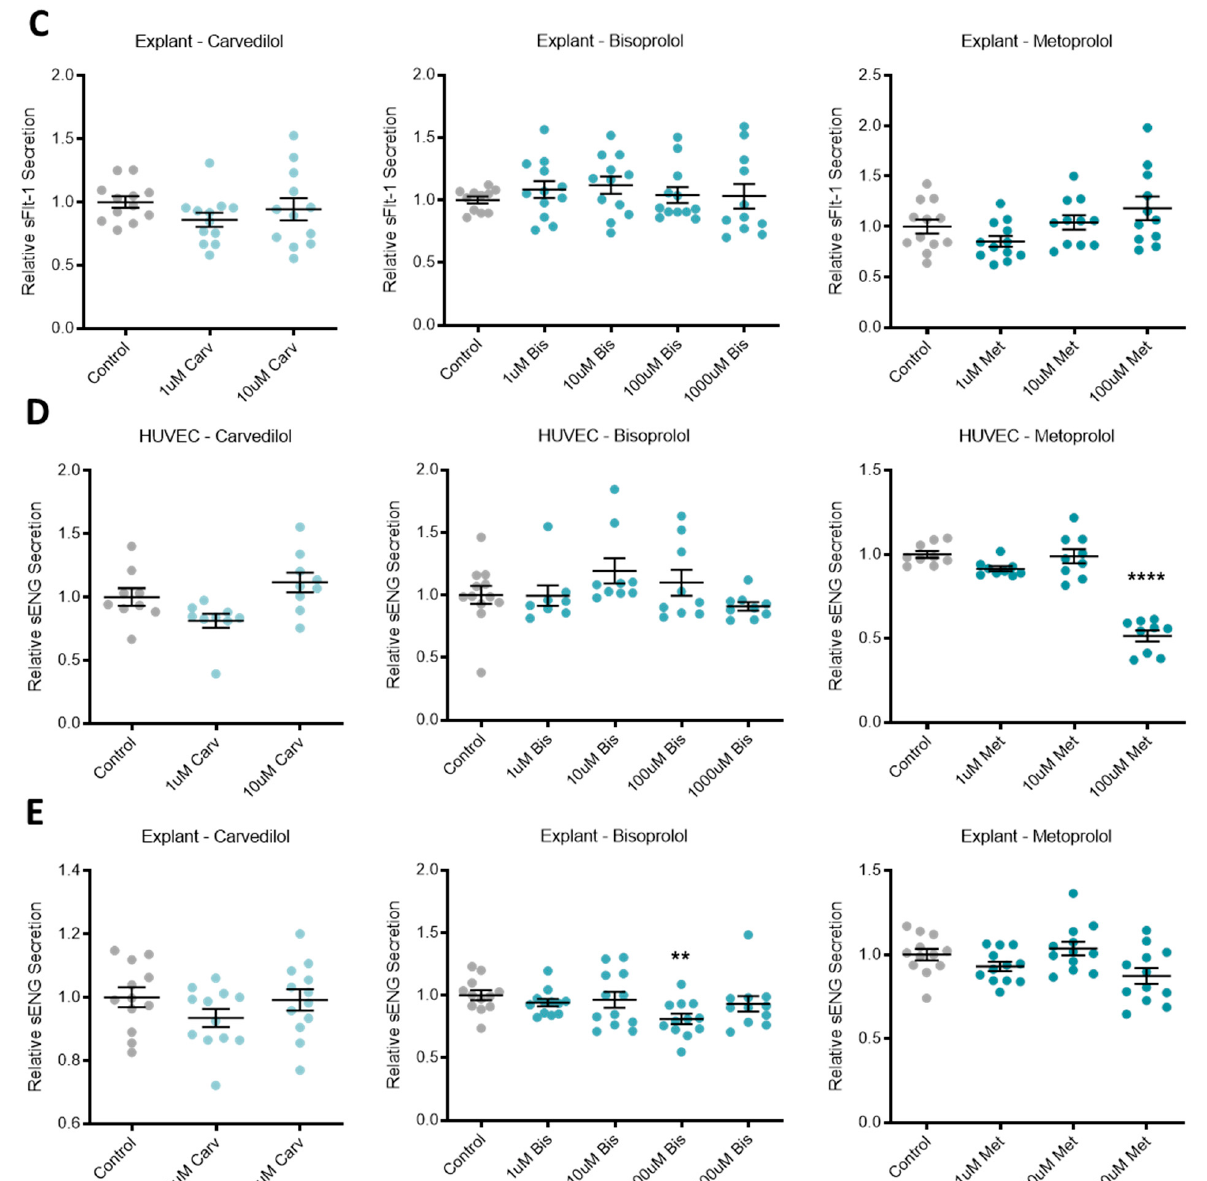
Figure 1. Beta-blockers had limited effect on secreted anti-angiogenic factors across different tissue types. Relative sFlt-1 secretion in HUVCEs ( A ) was significantly reduced with carvedilol (Carv) treatment, but not bisoprolol (Bis) treatment or metoprolol (Met) treatment. Relative sFlt-1 secretion was unchanged in trophoblasts ( B ) and explants ( C ) following beta-blocker treatment with Carv, Bis and Met. In HUVEC, relative sENG secretion ( D ) was decreased with treatment at the top dose of Met, but unchanged with Carv and Bis treatment. In explants, relative sENG secretion ( E ) was decreased with treatment at 100 uM Bis, but unchanged at the other doses or with Carv or Met. Data are mean ± SEM, expressed relative to control, n = 3–4, ** p < 0.01, **** p < 0.0001.